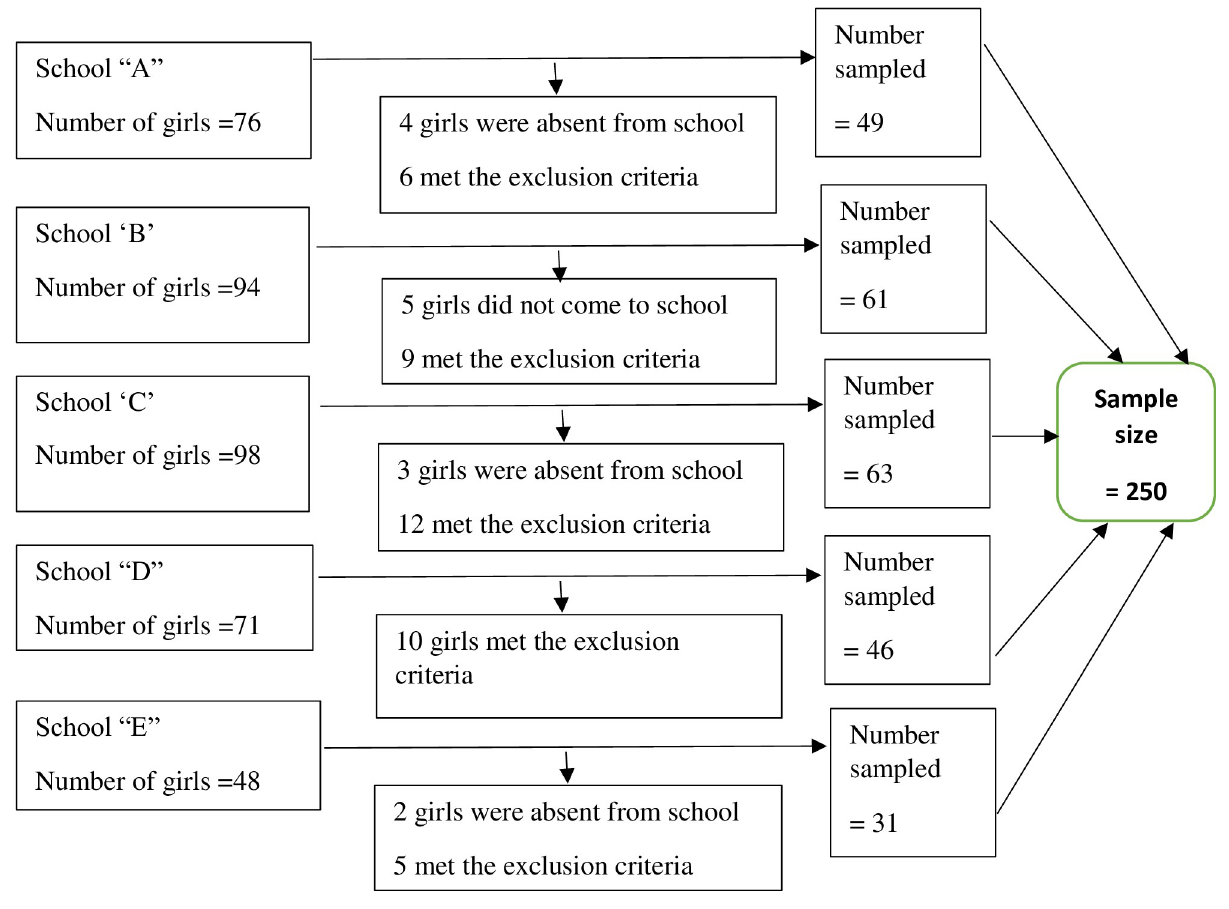
Fig 1. Proportional sampling of